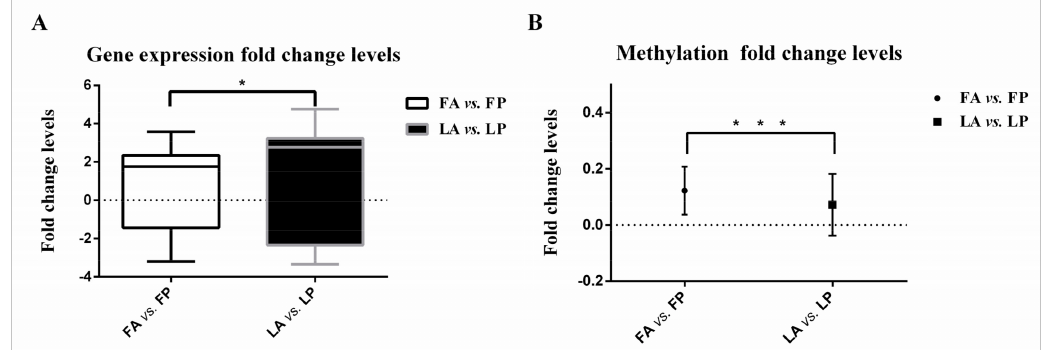
Figure 1. Gene and methylation expression fold change levels in Fayoumi and Leghorn breeds. ( A ) Gene expression fold change levels of top-fold change genes with false discovery rate (FDR)-corrected p < 0.05, which were measured as the variance of log 2 (gene expression levels of individuals with avian influenza virus (AIV) inoculation / gene expression levels of individuals challenged with phosphate bu ff er saline (PBS)). The comparison used F-tests, the y-axis represents mean with SD (Standard Deviation), and * indicates a significance level of 0.05; ( B ) methylation fold change levels of di ff erentially methylated regions, which were measured as the variance of log 2 (methylation ratios of individuals with AIV inoculation / methylation ratios of individuals challenged with PBS). The comparison used F-tests, the y-axis represents the mean with SD, and *** indicates a significance level of